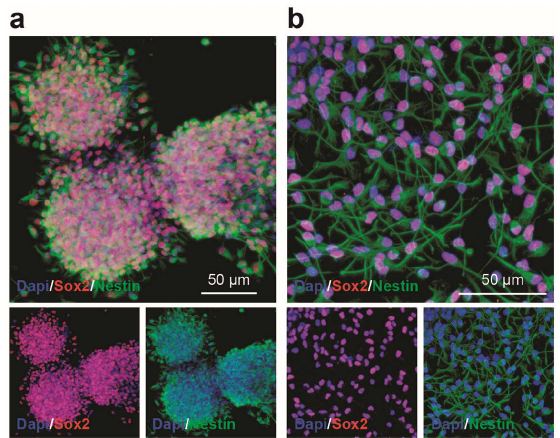
Figure 1. Mouse neural stem cells (NSCs) express Sox2 and Nestin, in vitro. ( a , b ) Representative confocal microscopy pictures of NSCs grown as neurospheres ( a ) and monolayer ( b ) expressing Sox2 (red) and Nestin (green). Nuclei were counterstained with Dapi (blue).